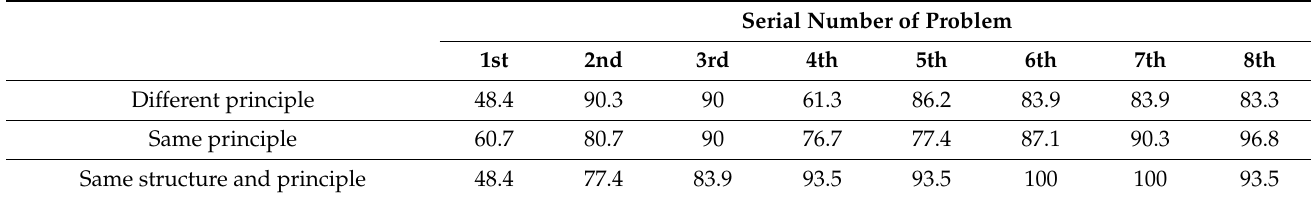
Table 1. Percentage of endogenous solutions in different